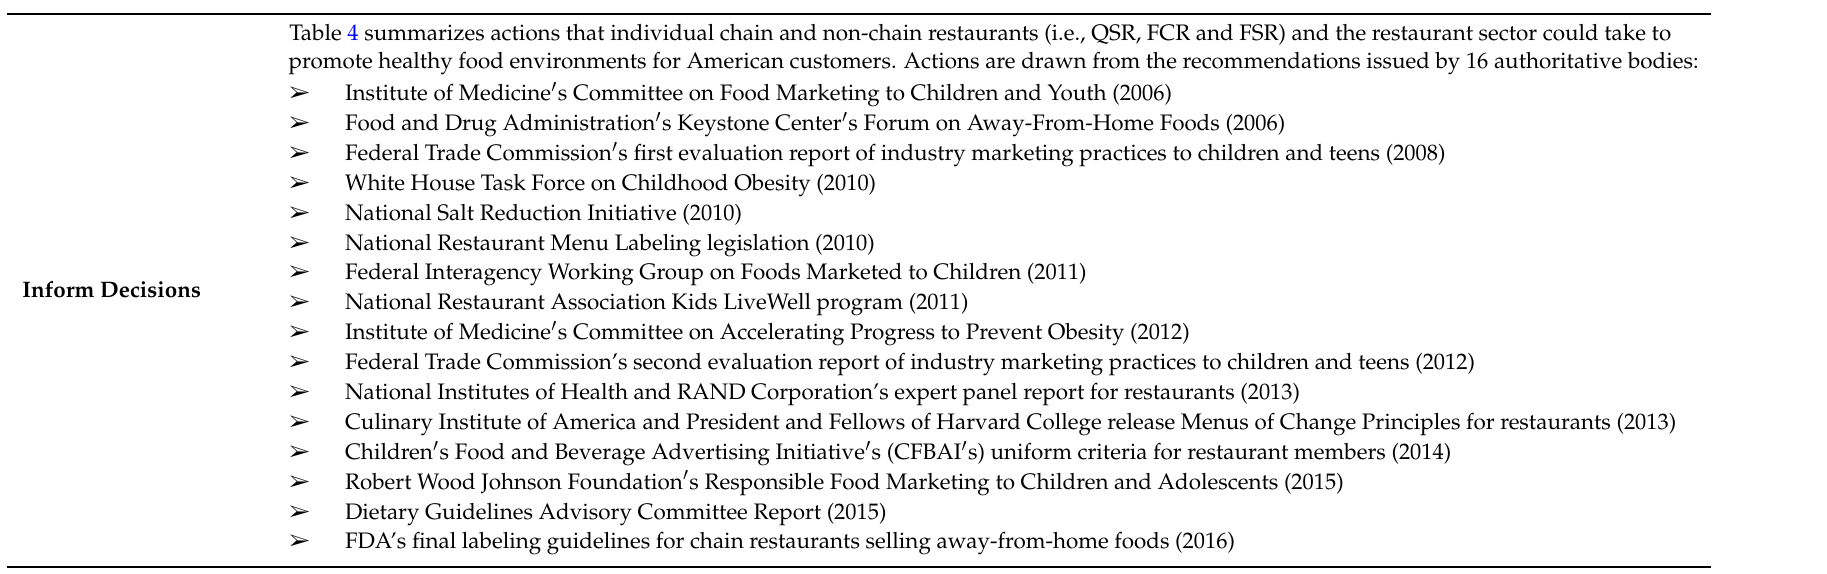
Table 4 summarizes actions that individual chain and non-chain restaurants (i.e., QSR, FCR and FSR) and the restaurant sector could take to promote healthy food environments for American customers. Actions are drawn from the recommendations issued by 16 authoritative